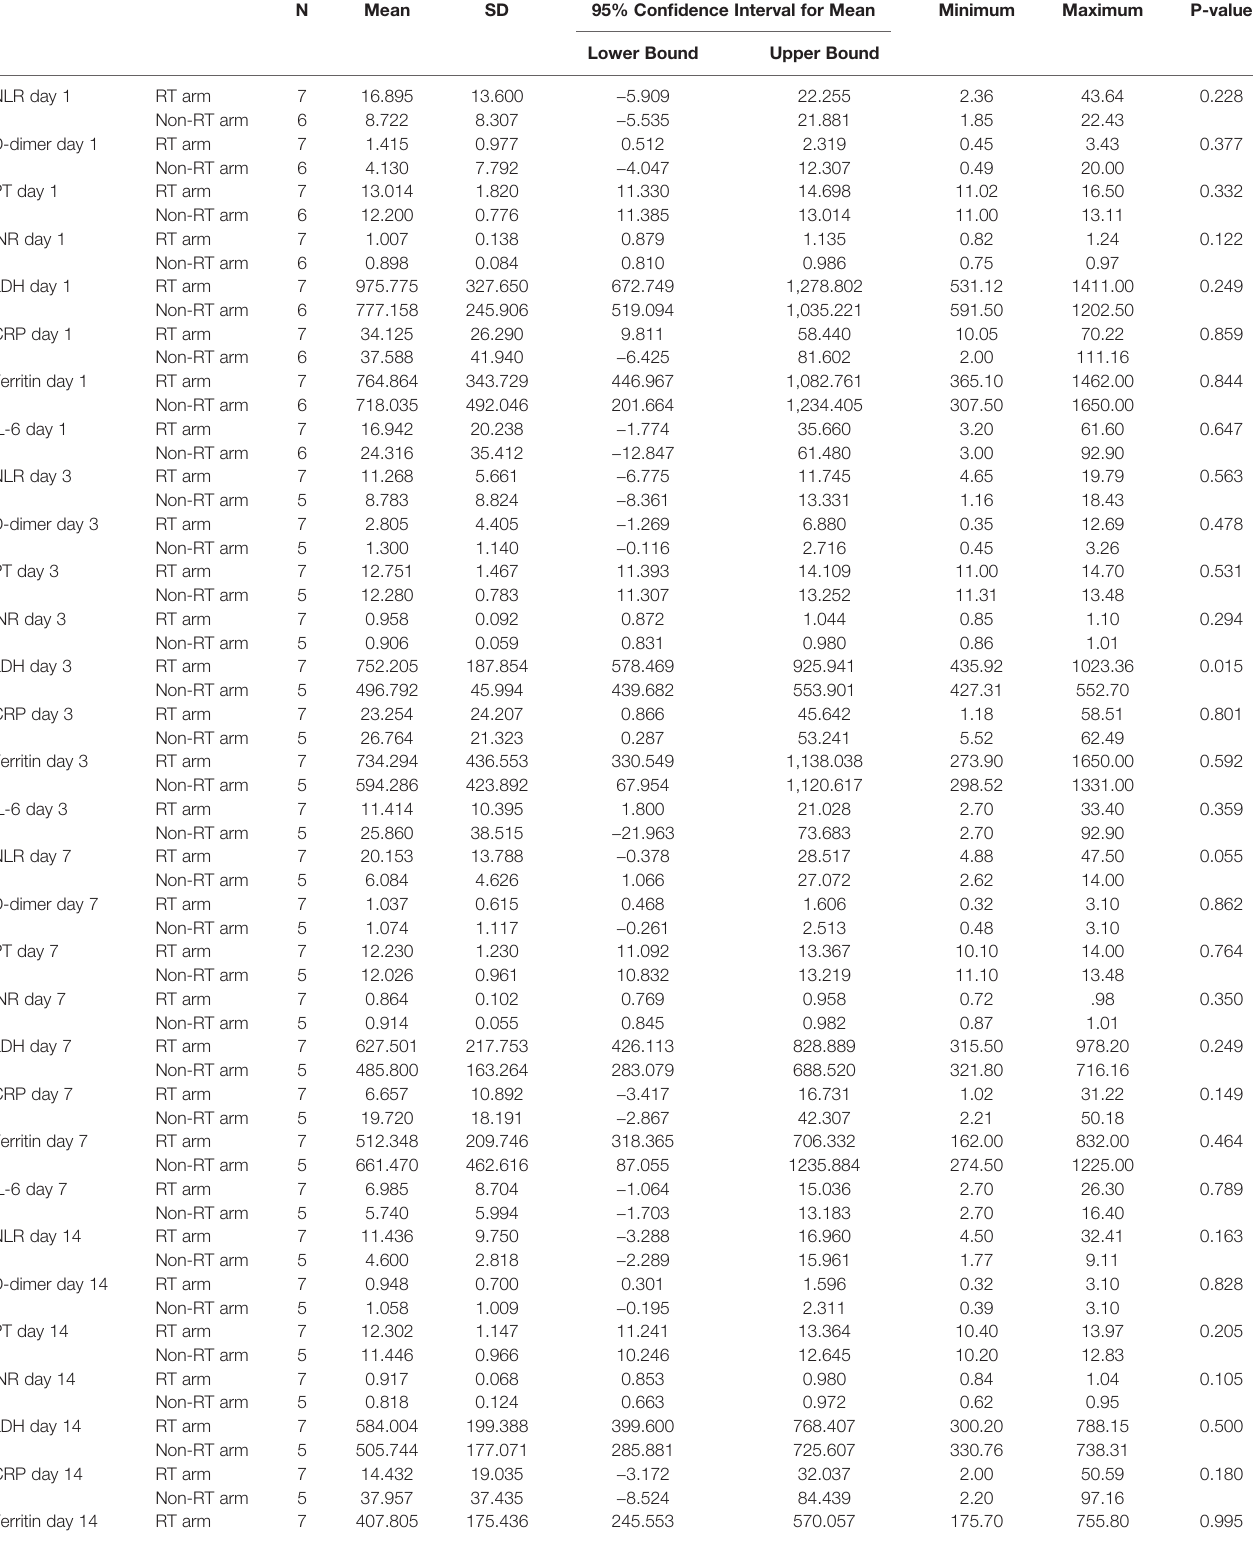
TABLE 3 | Comparison of different biochemical parameters on the day of LDRT and serial follow up. N Mean SD 95% Con fi dence Interval for Mean Minimum Maximum P-value Lower